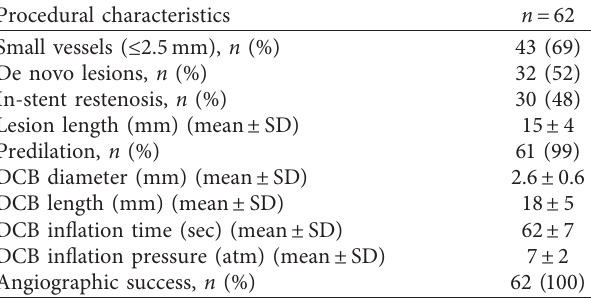
Table 2: Procedural characteristics.